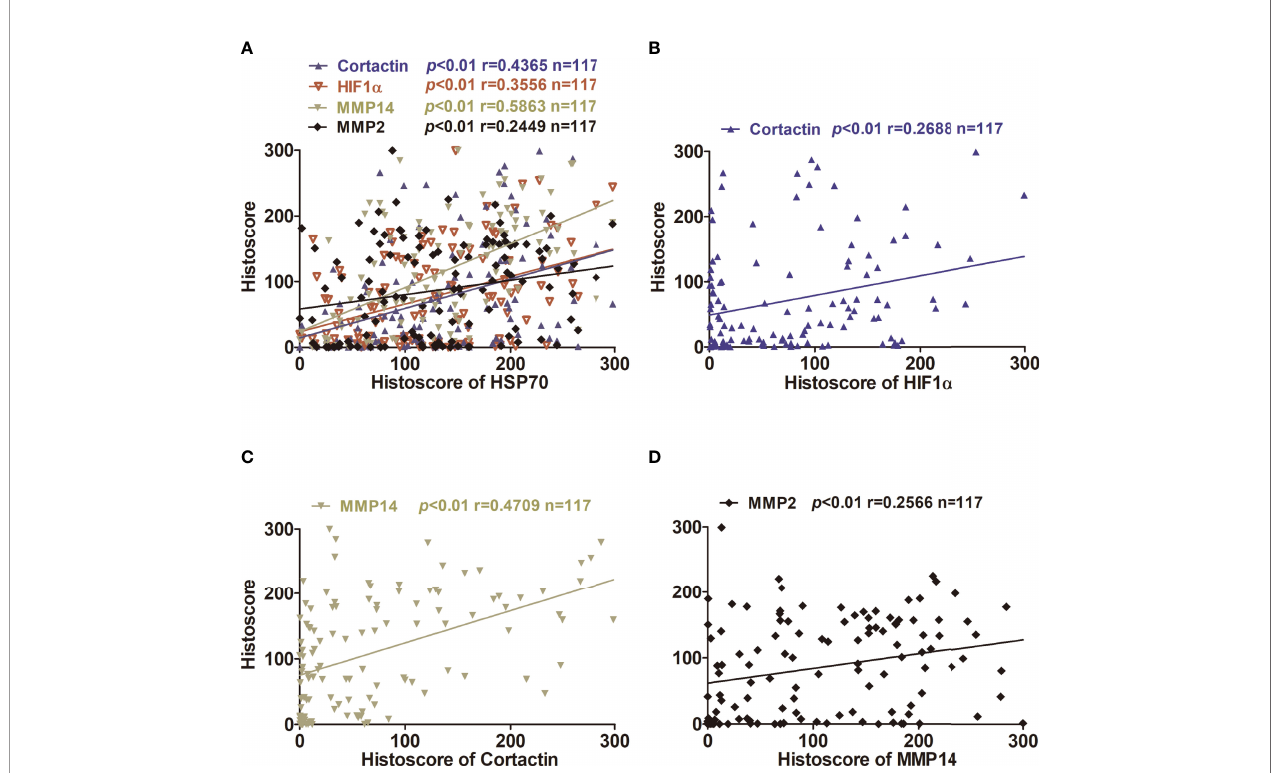
FIGURE 3 | Correlation and regression of HSP70, Hif1 a , MMP2, MMP14, and cortactin in OSCC tissues using two-tailed Pearson ’ s test. (A) A correlation and regression of HSP70, Hif1 a , MMP2, MMP14, and cortactin in OSCC tissues using two-tailed Pearson ’ s test. (B) Correlation between Hif1 a and cortactin expression levels in OSCC tissues. (C) Correlation between MMP14 and cortactin expression levels in OSCC tissue. (D) Correlation between MMP2 and MMP14 expression levels in OSCC tissues.